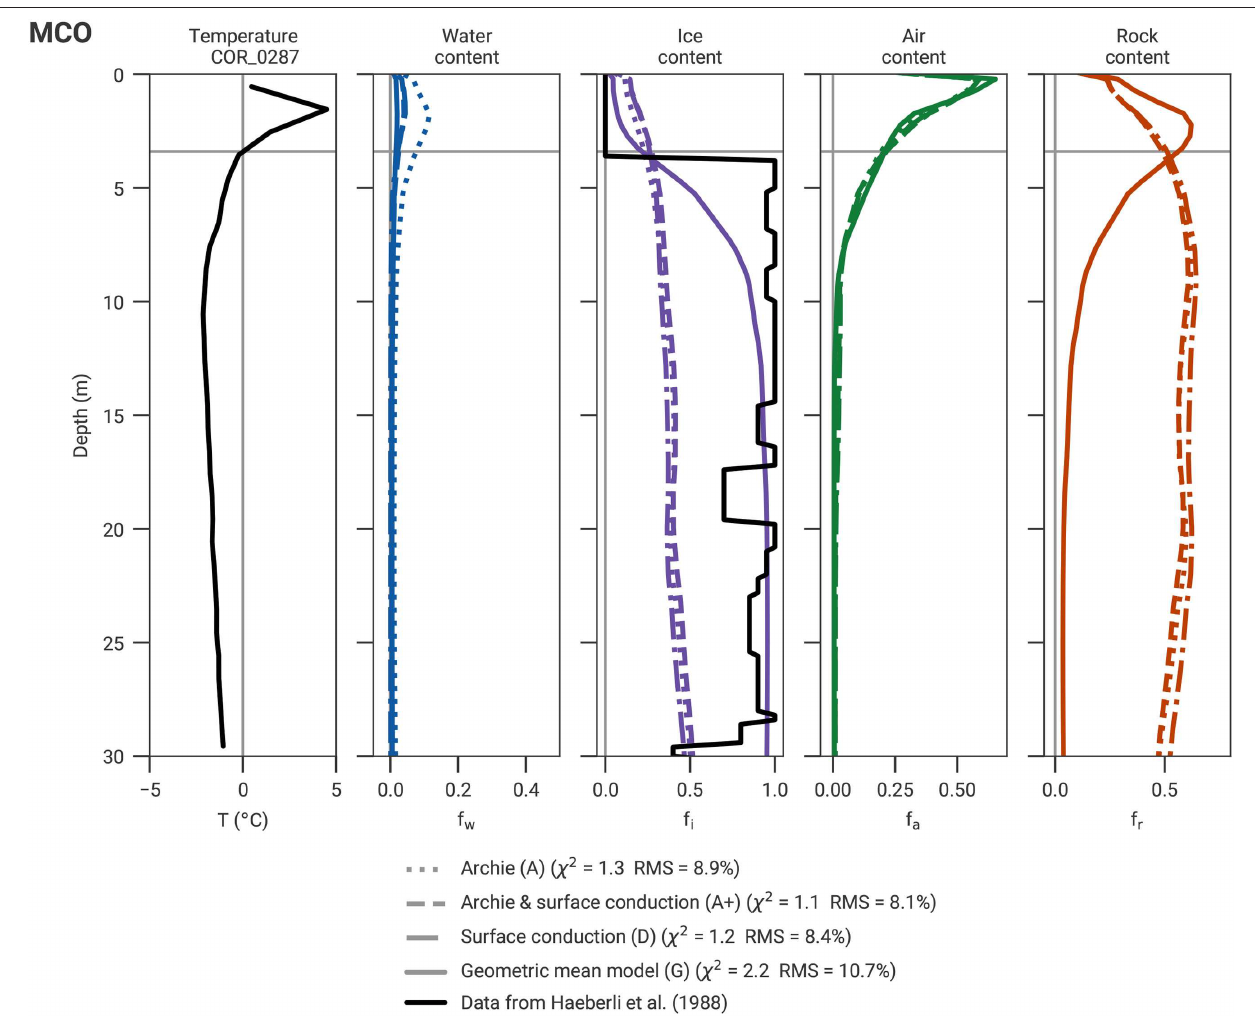
FIGURE 9 | Borehole temperature measured in COR_0287 and corresponding four-phase constituents estimated by the joint inversion for the Murtél profile. The ice content data derived from density measurements ( Haeberli et al., 1988) is included. 0 ◦ C temperature lines and thaw depths are marked by gray